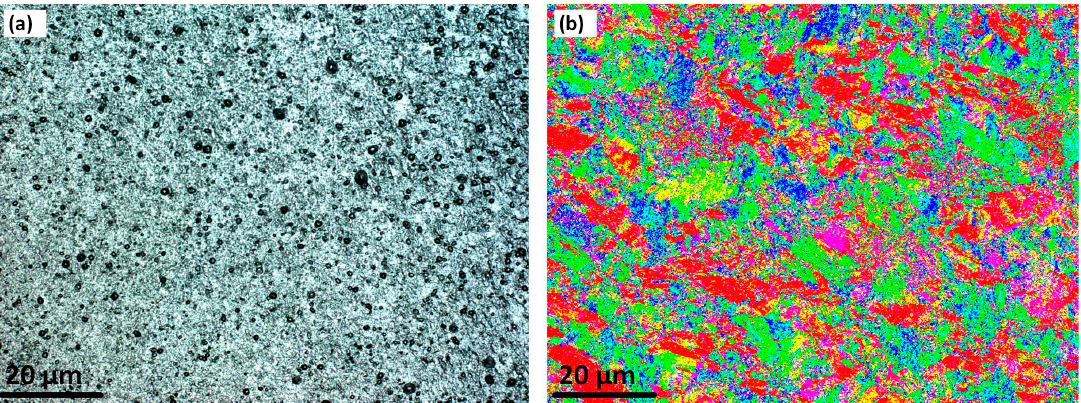
Figure 5. The microstructure of the Mid-Stirring Zone (SZ) region, ( a ) Optical microscopy and ( b ) EBSD colour map.